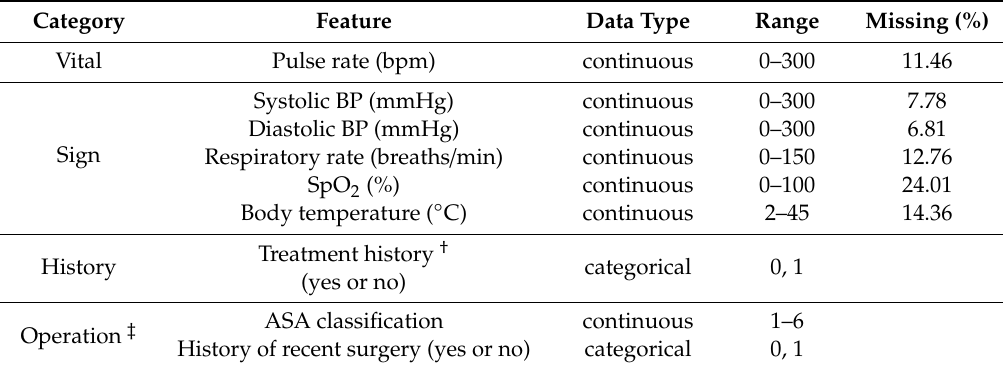
Table 1. List of